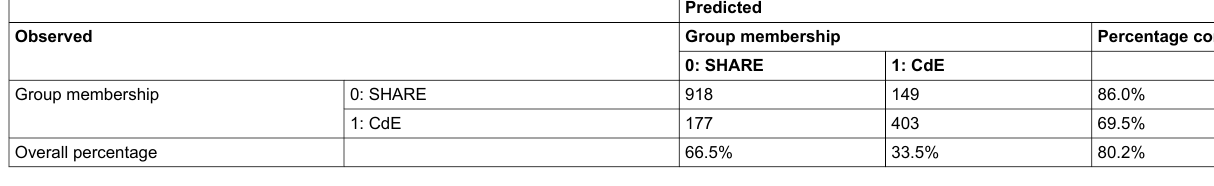
Table 2: Classification table of the observed and predicted cases by logistic regression.